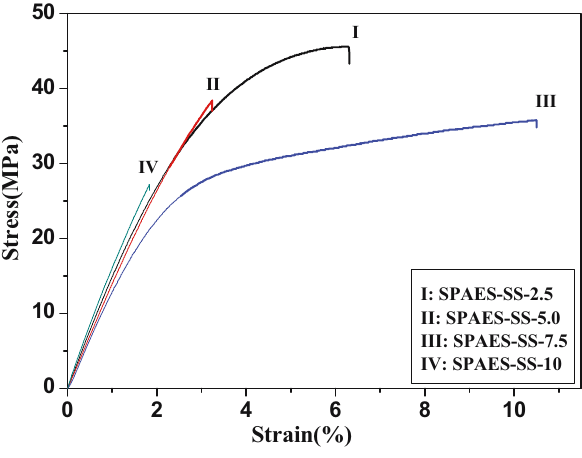
Figure 5: Stress – strain plot of the hybrid